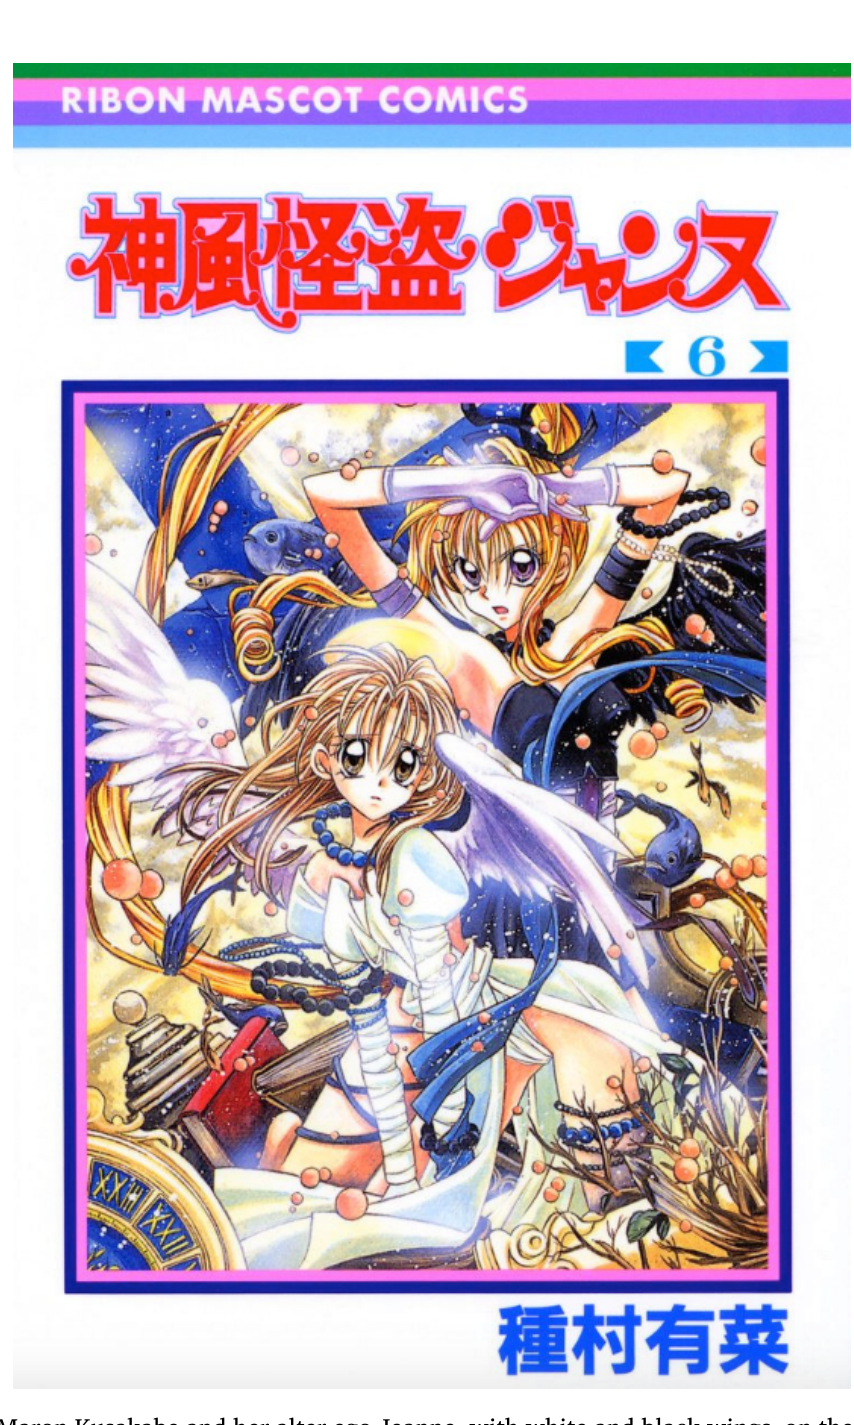
Figure 1 Maron Kusakabe and her alter ego Jeanne, with white and black wings, on the cover of the sixth volume of manga Kamikaze Kaitō Jeanne (Tanemura